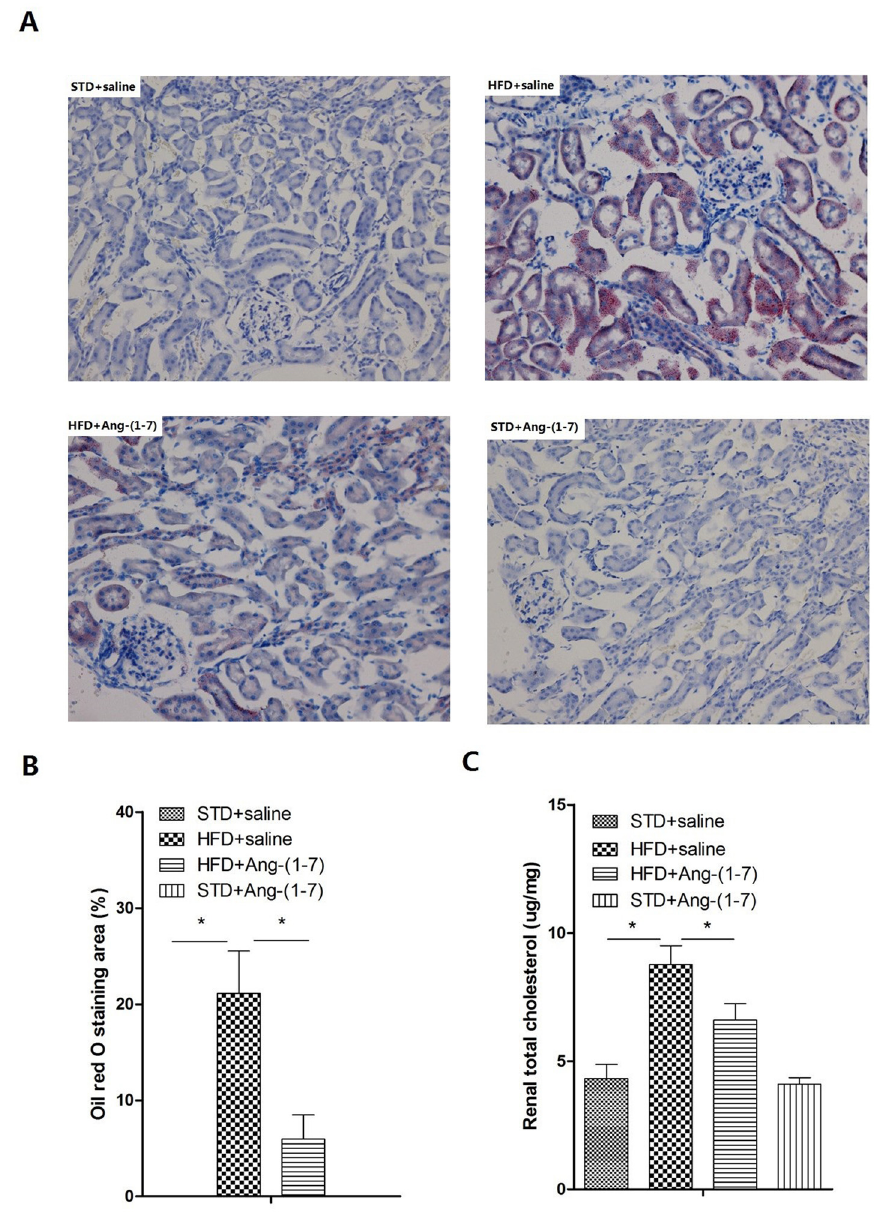
Fig 6. Renal lipid accumulation in mice. Ang-(1 – 7) ameliorates HFD-induced renal lipid deposition. A: Oil Red O staining (magnification 200×). Representative Oil Red O staining in renal sections. Red spots signify lipid drops. HFD induces significant accumulation of lipid drops in kidney, which is reduced upon treatment with Ang-(1 – 7). B: Representative quantitative analysis of Oil Red O staining. Values are expressed as means ± SD (n = 6). C: Measurement of renal total cholesterol as described in Materials and Methods. Values are expressed as means ± SD (n = 6), * P <